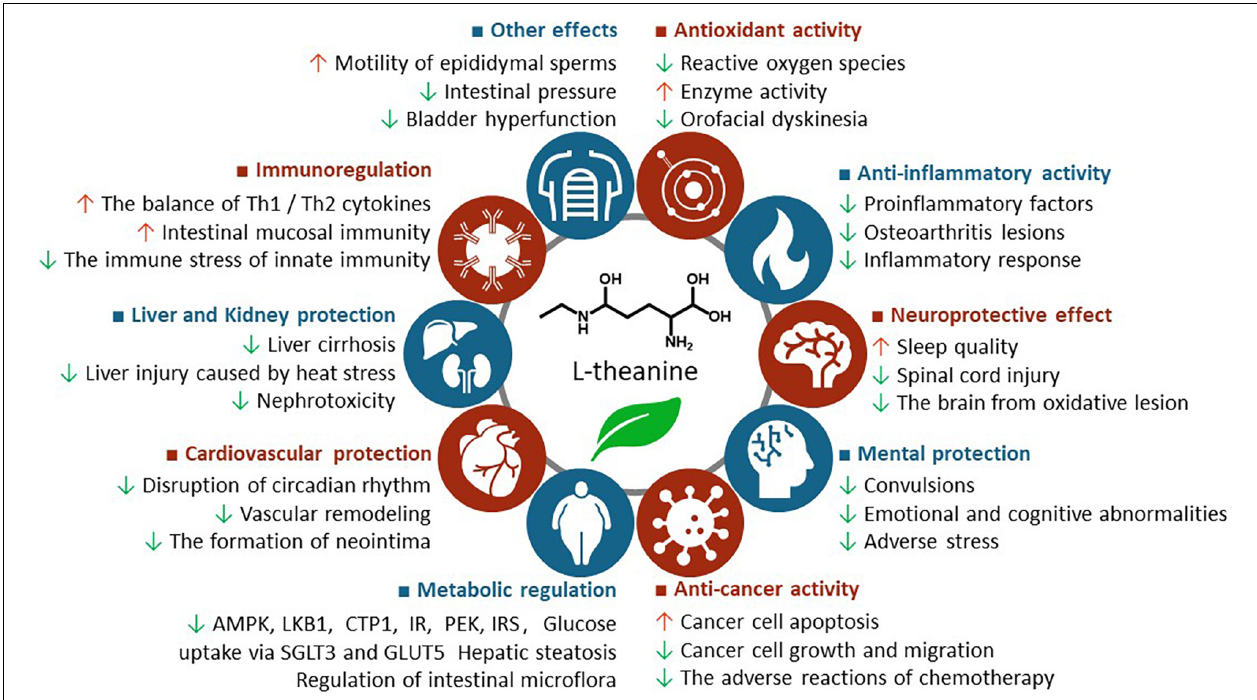
FIGURE 2 | The health benefits of L-theanine. AMPK, adenosine 5 (cid:48) -monophosphate-activated protein kinase; CPT1, carnitine palmitoyltransferase 1; IR, insulin receptor; IRS, insulin receptor substrate; LKB1, liver kinase B1; PFK,